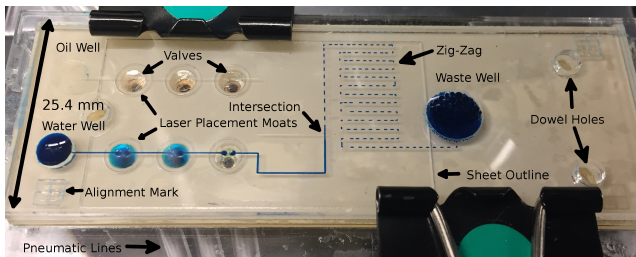
Figure 5. Under the conditions of minimal backstep, the chip (with features as defined in Figure 1c) generates a uniform train of droplets of water (blue) in oil (clear) that are drawn from the oil and water reservoirs on the left and marched through a complex structure to a waste well on the right. The chip is 76.2 mm × 25.4 mm, and underneath are the six brass fittings screwed into the base of the chip, each connecting to an output from the pneumatic controller, which is in turn controlled via a laptop computer. The laser placement moats and sheet outline are from the laser placement of the HDPE membranes and are not connected fluidically. The pneumatic tubing can be seen underneath the water valves. The yellow appearance of some of the valves is due to reflected light from the brass pneumatic